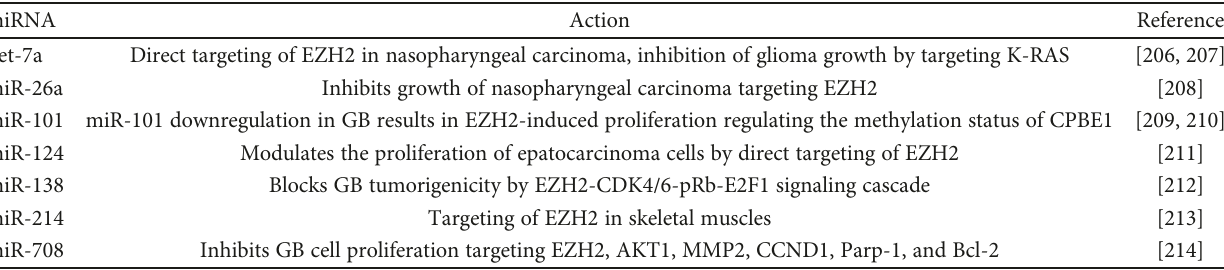
Table 2: miRNA involved in the regulation of